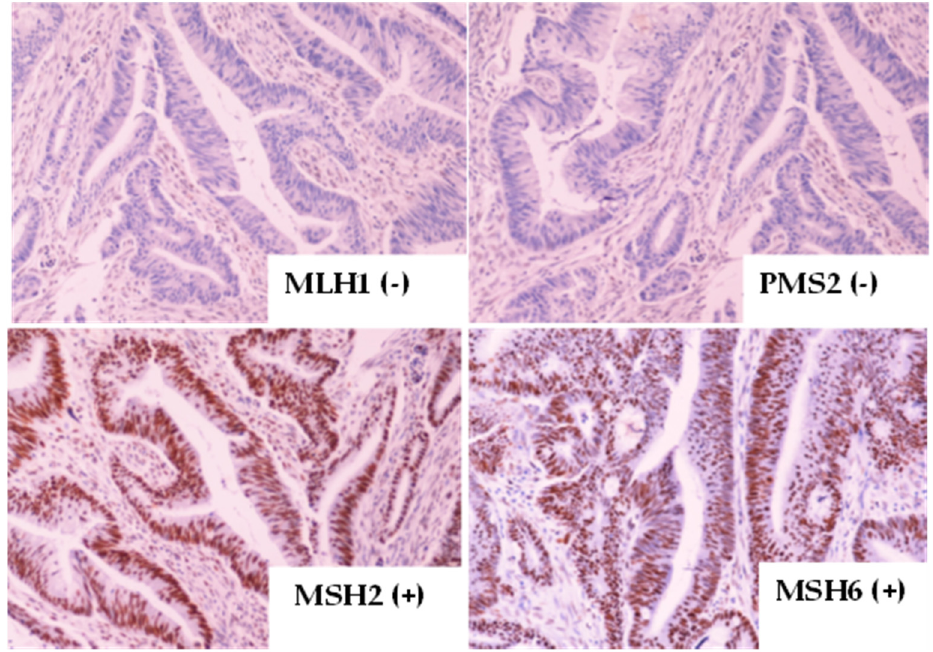
Figure 1. Colorectal cancer tissue with MLH1 and PMS2 negative expression (absence of nuclear staining) and MSH2 and MSH6 positive expression (presence of nuclear